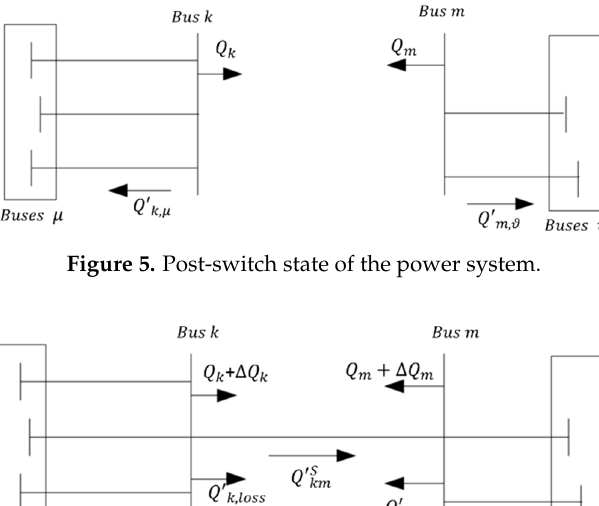
Figure 4. Pre-switch state of the power system.